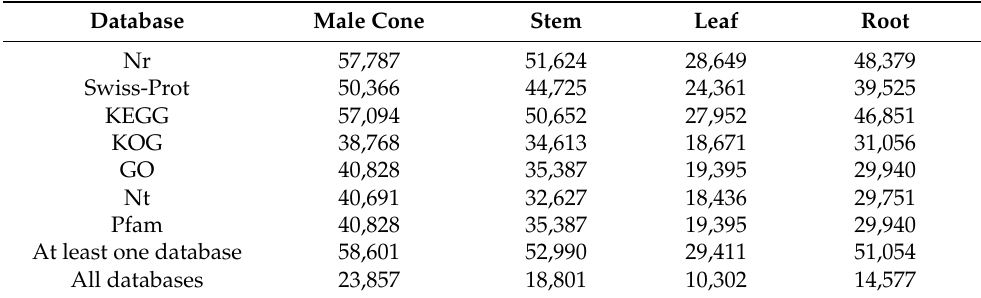
Table 1. Statistics of annotations of the full-length transcripts from four tissues of C. oliveri with seven